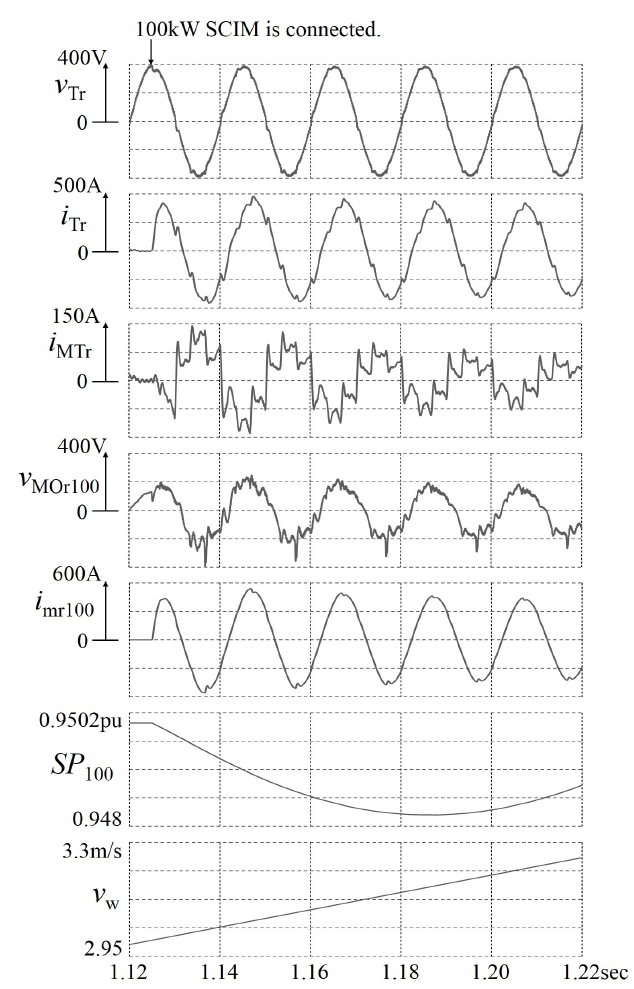
Figure 14. Simulation waveforms with the proposed inrush current suppressor for the 100-kW